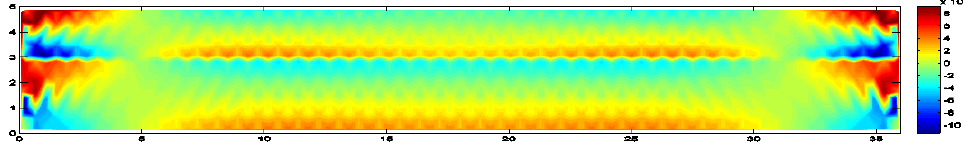
Figure 14. The contour of 𝜎 𝑥 of the lower beam by the NMK- α method.